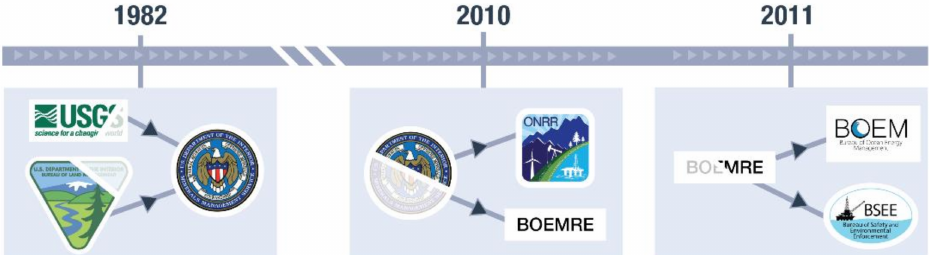
Figure 1. After the passage of the Federal Oil and Gas Royalty Management Act, the DOI created the MMS in 1982 by combining elements of BLM and USGS. In 2010, MMS split into the Bureau of Ocean Energy Management, Regulation and Enforcement (BOEMRE) and ONRR. In 2011, BOEMRE was reorganized into the BOEM and